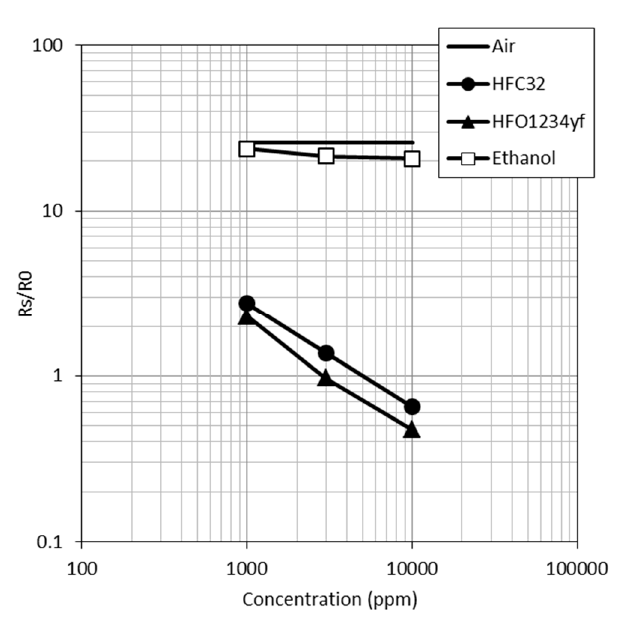
Figure 2. Sensitivity characteristics of TGS2630, R0: sensor resistance at 5000 ppm